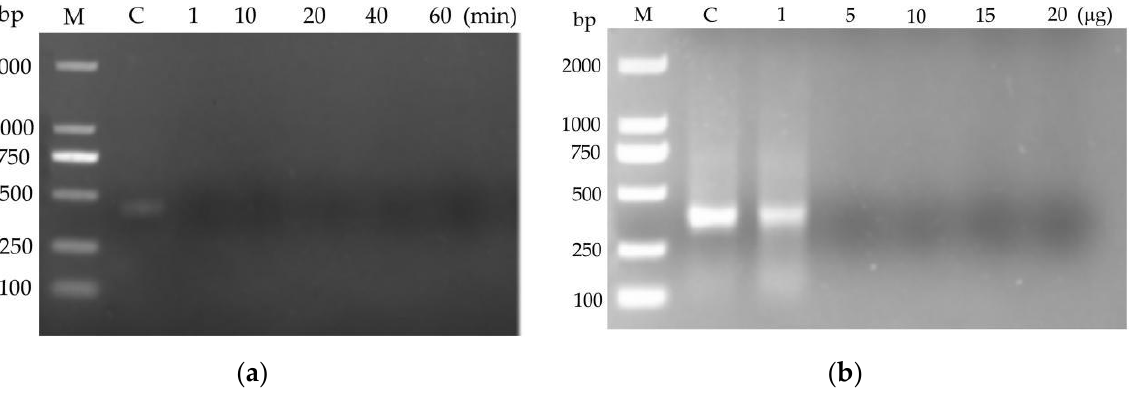
Figure 7. Degradation of dsRNA by the crude CmdsRNase. ( a ) Degradation of dsRNA (120 ng) by 10 μ g crude CmdsRNase at different times. ( b ) Degradability of dsRNA (120 ng) by different quan- tities of crude CmdsRNase within 5 min. M: DL2000 DNA marker; C: Control.